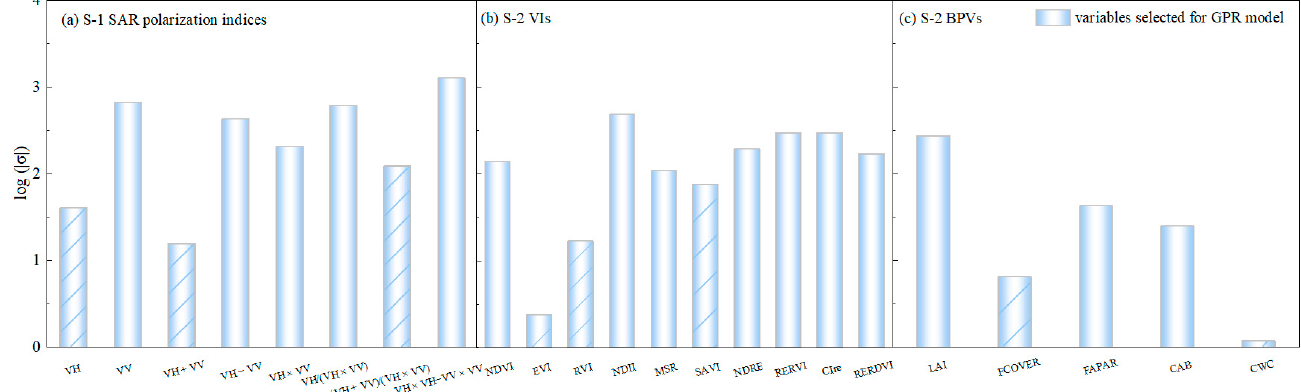
11 of 22 Figure 3. Measured vs. estimated biomass by the optimal models for each dataset ( a ) All SAR po- larization indices with GPR, ( b ) all VIs with GPR, and (c) FCOVER with RF. The different colors indicated the 5-fold subsets. 3.2. Performance of GPR and RF on Estimating Maize Biomass with Feature Optimization 3.2.1. Performance of GPR-Optimized by Feature Relevance As noted earlier, one interesting feature of GPR is its ability to provide insight into the relevance of input predictors when developing the regression model. The σ in the ker- nel function of GPR is interpreted as the relevance of the predictor, which means the lower σ , the more relevant the predictor [70]. We calculated σ for each group of input predictors